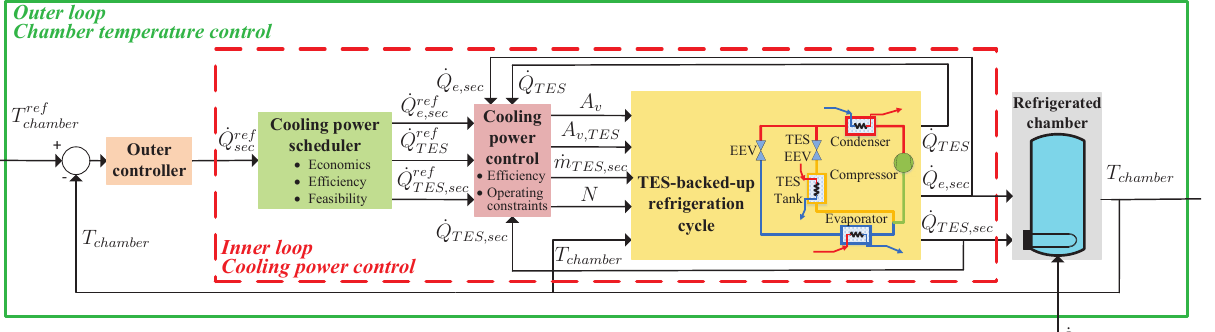
Figure 6. Scheduling and control strategy for the TES-backed-up refrigeration